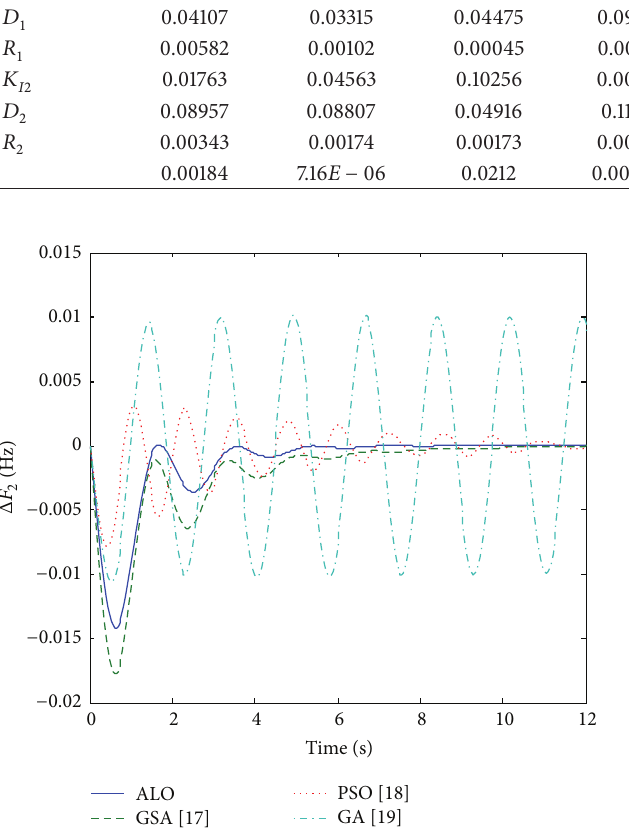
Figure 8: Change in frequency of area 2 by 20% load increase in area 2.